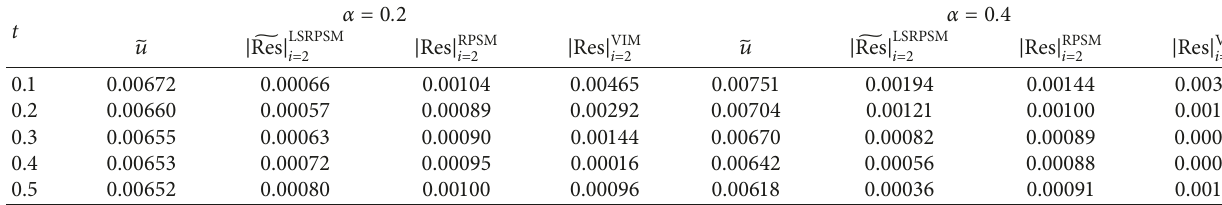
Figure 2: Approximate solution: (a) 􏽥 u ( x,t, α � 0 . 35 ) ; (b) 􏽥 u ( x,t, α � 0 . 55 ) ; (c) 􏽥 u ( x, t, α � 0 . 75 ) ; (d) 􏽥 u ( x,t, α � 0 . 95 ) Table 2: The values of | 􏽦 Res ( x,t )| by LSRPSM, RPSM, and VIM for α � 0 . 2 , 0 . 4 and x � − 10.